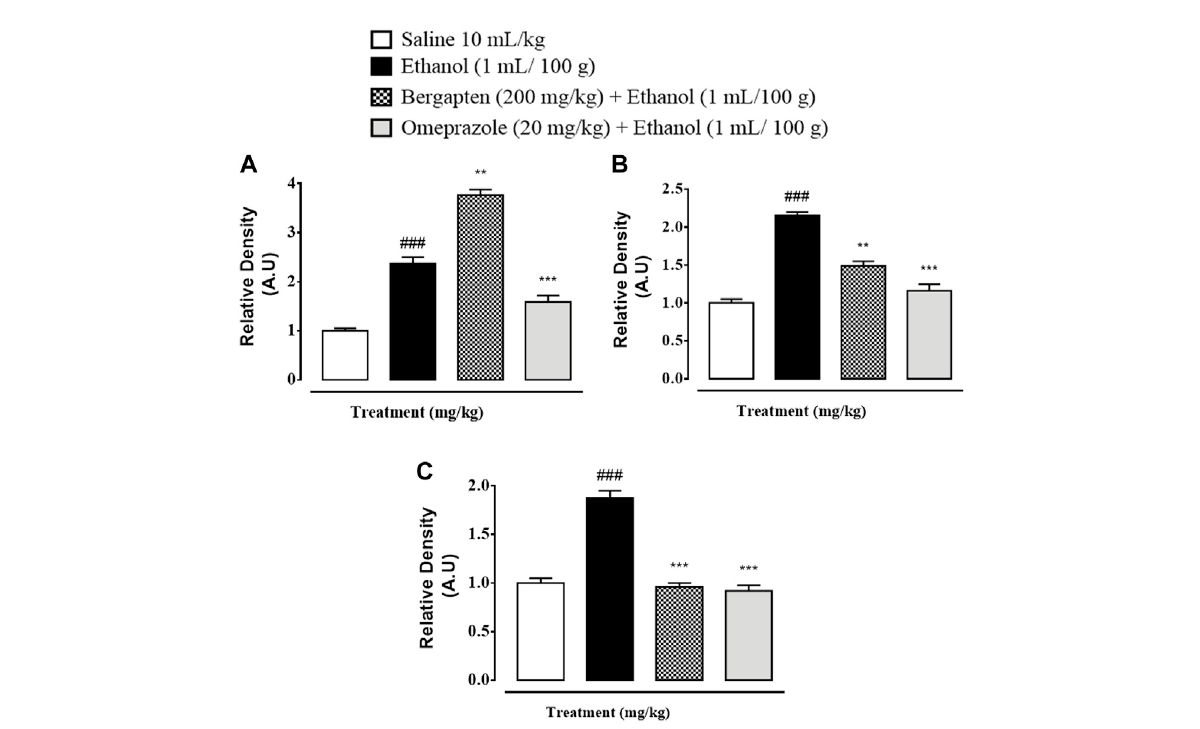
FIGURE 12 Graphical representation showing inhibitory effect of bergapten and omeprazole groups against (A) phosphorylated nuclear factor kappa B (pNF-Kb), (B) tumor necrosis factor alpha (TNF- α ), and (C) cyclooxyegenase 2 (COX-2) in ethanol-treated gastric tissues using western blot techniques. The data are expressed as mean ± SEM ( n = 3). One-way ANOVA with post hoc Tukey ’ s test. ### p < 0.001 vs. saline group, *** p < 0.001, ** p < 0.01 vs. ethanol